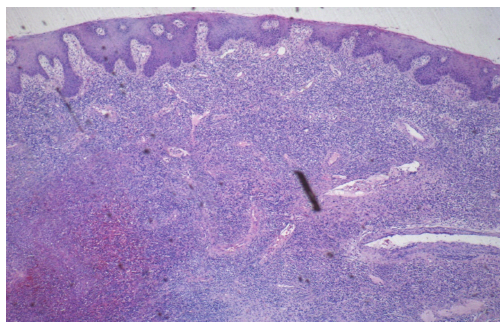
Figure 3: Anal ulcer biopsy showing atypical mucosal and submu- cosal hematopoietic cell